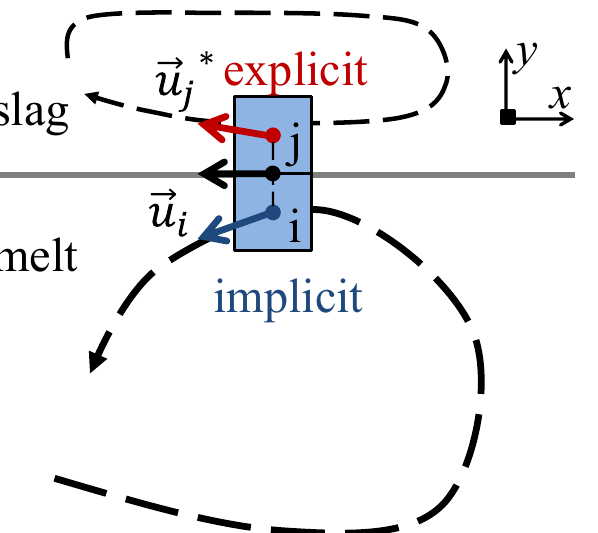
Figure 3. Splitting convection at the melt/slag interface and the coupling momentum transfer of two phases.